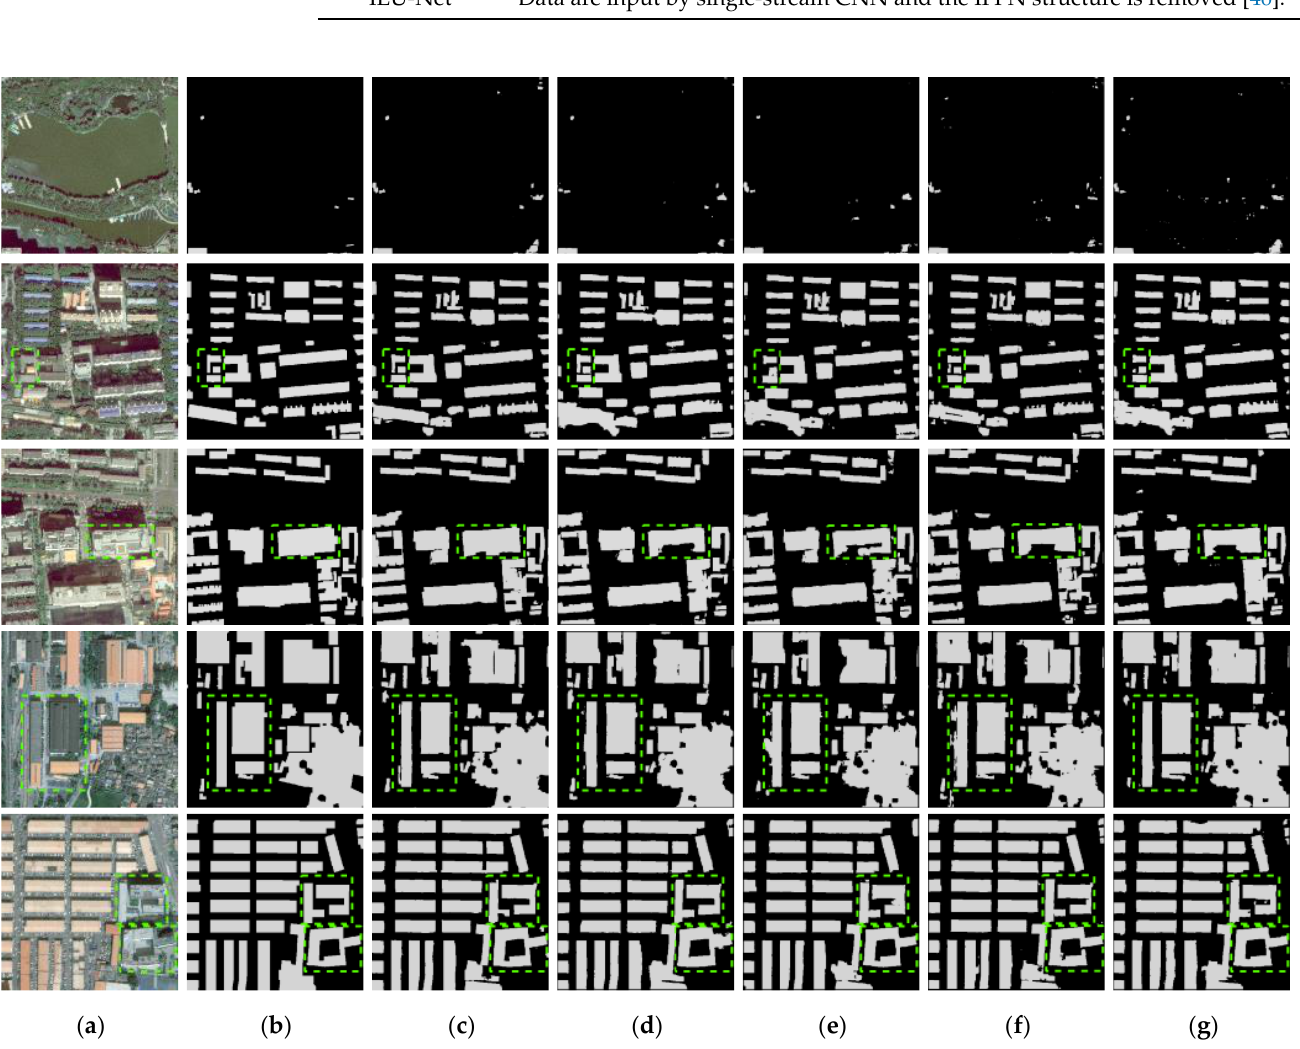
Figure 10. Building extraction results for different network structures. ( a ) Image; ( b ) Label; ( c ) DMU- Net; ( d ) DMU-Net (FPN); ( e ) SMU-Net; ( f ) DU-Net; ( g ) IEU-Net.